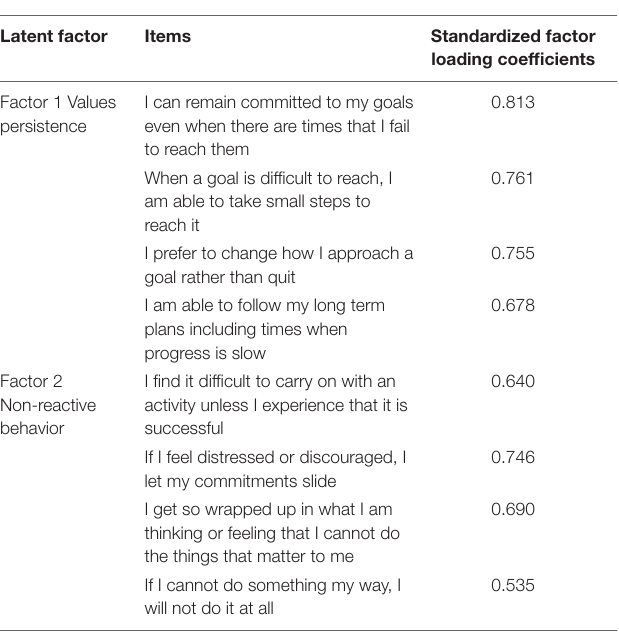
TABLE 3 | Factor loadings of the Committed Action Questionnaire (CAQ-8)